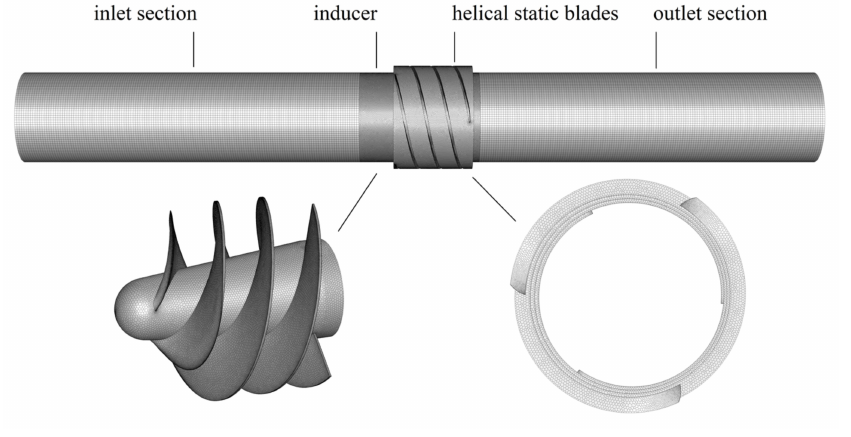
Figure 2. Computed area and calculated